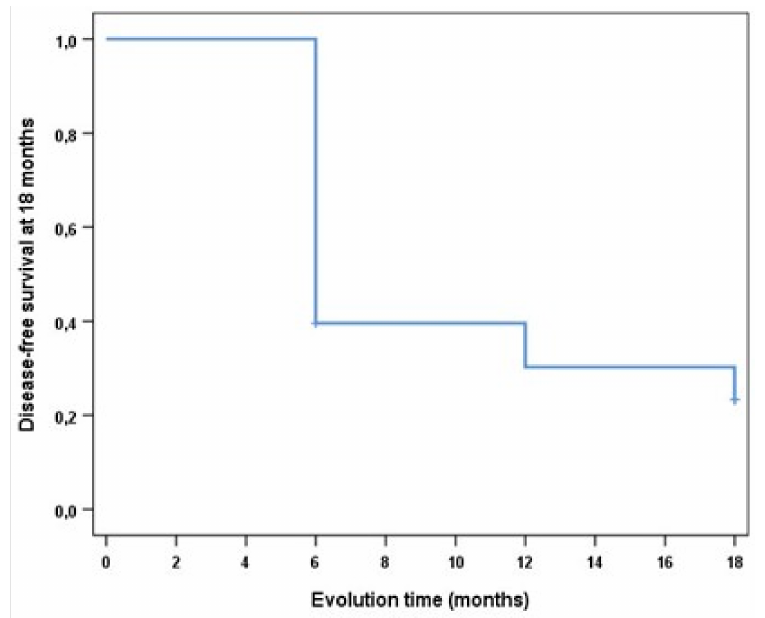
Figure 4. Survival curve developed by the Kaplan-Meier method. Patient disease-free survival at 18 months was 23.3 ± 0.06, with an estimated 10.2 ± 0.8 months (95% CI = 8.63–11.8) on average until recurrence of the